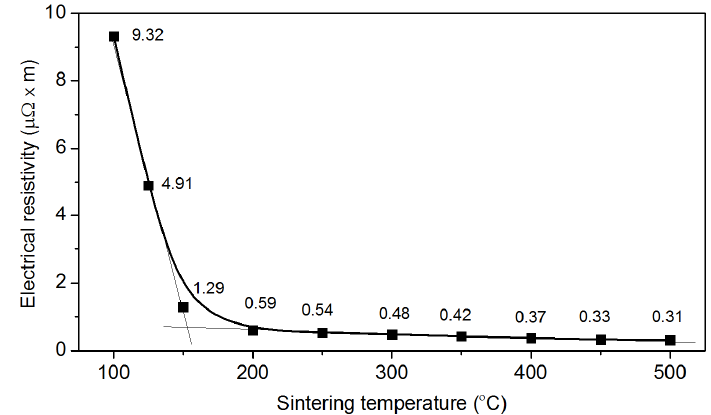
Figure 5 . The dependence of electrical resistivity on sintering temperature. Figure 5. The dependence of electrical resistivity on sintering